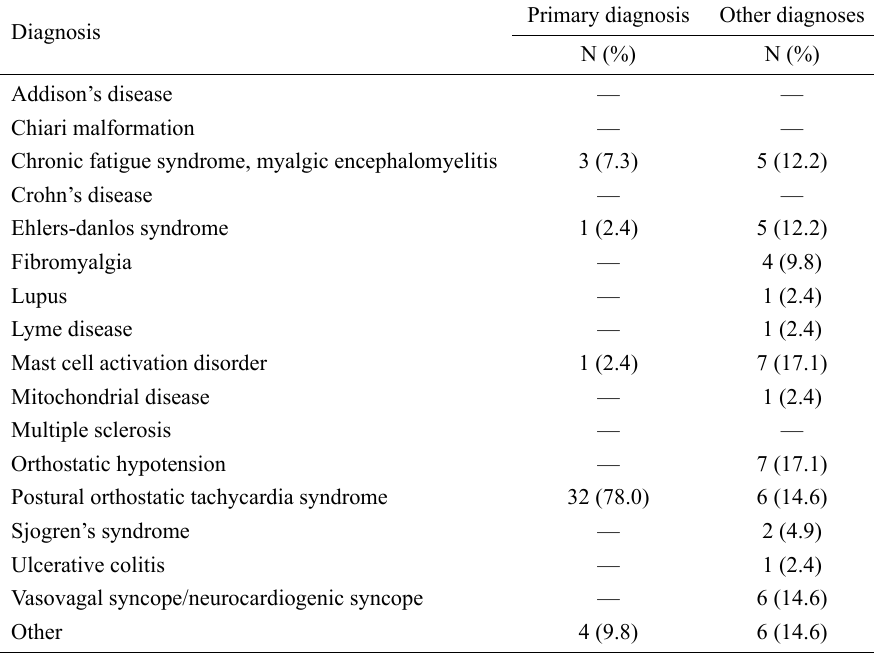
Table 2. Frequency and percentages of primary and other diagnoses (n = 41).